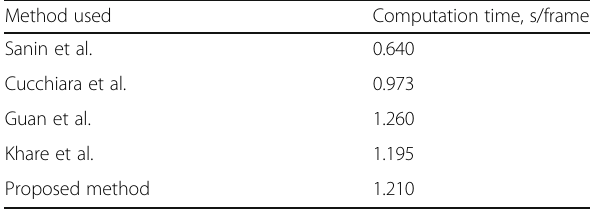
Table 3 Total computation time of various methods